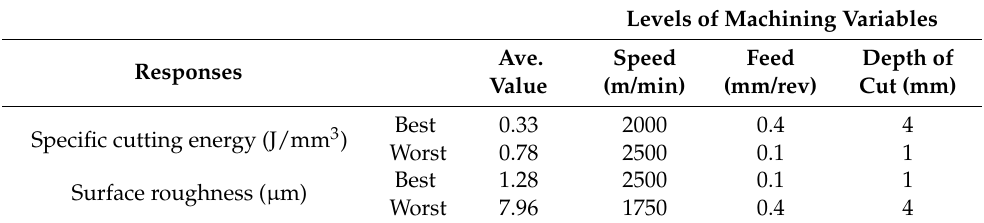
Table 15. Results of confirmatory experiments for high-speed